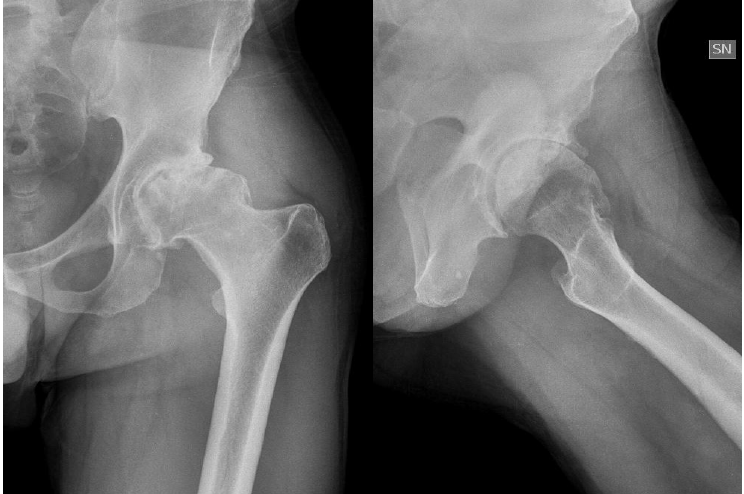
Figure 1. Forty-six-year-old haemophilic subject affected by severe haemophilia A, with inhibitors, Figure 1. Forty ‐ six ‐ year ‐ old haemophilic subject affected by severe haemophilia A, with inhibitors, with symptomatic left hip arthropathy secondary to femoral acetabular with symptomatic left hip arthropathy secondary to femoral acetabular impingement.